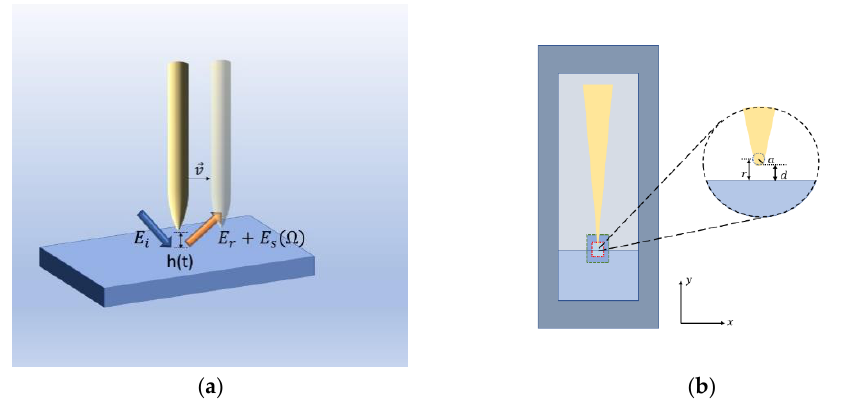
Figure 1. ( a ) Schematic illustration of the probe in s-SNOM; ( b ) near-field scattering simulation model.